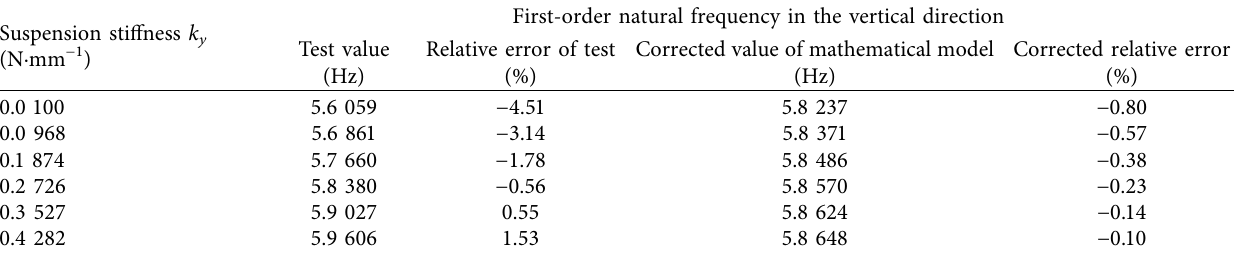
Table 5: Natural frequencies of the threefold solar array in the vertical direction.